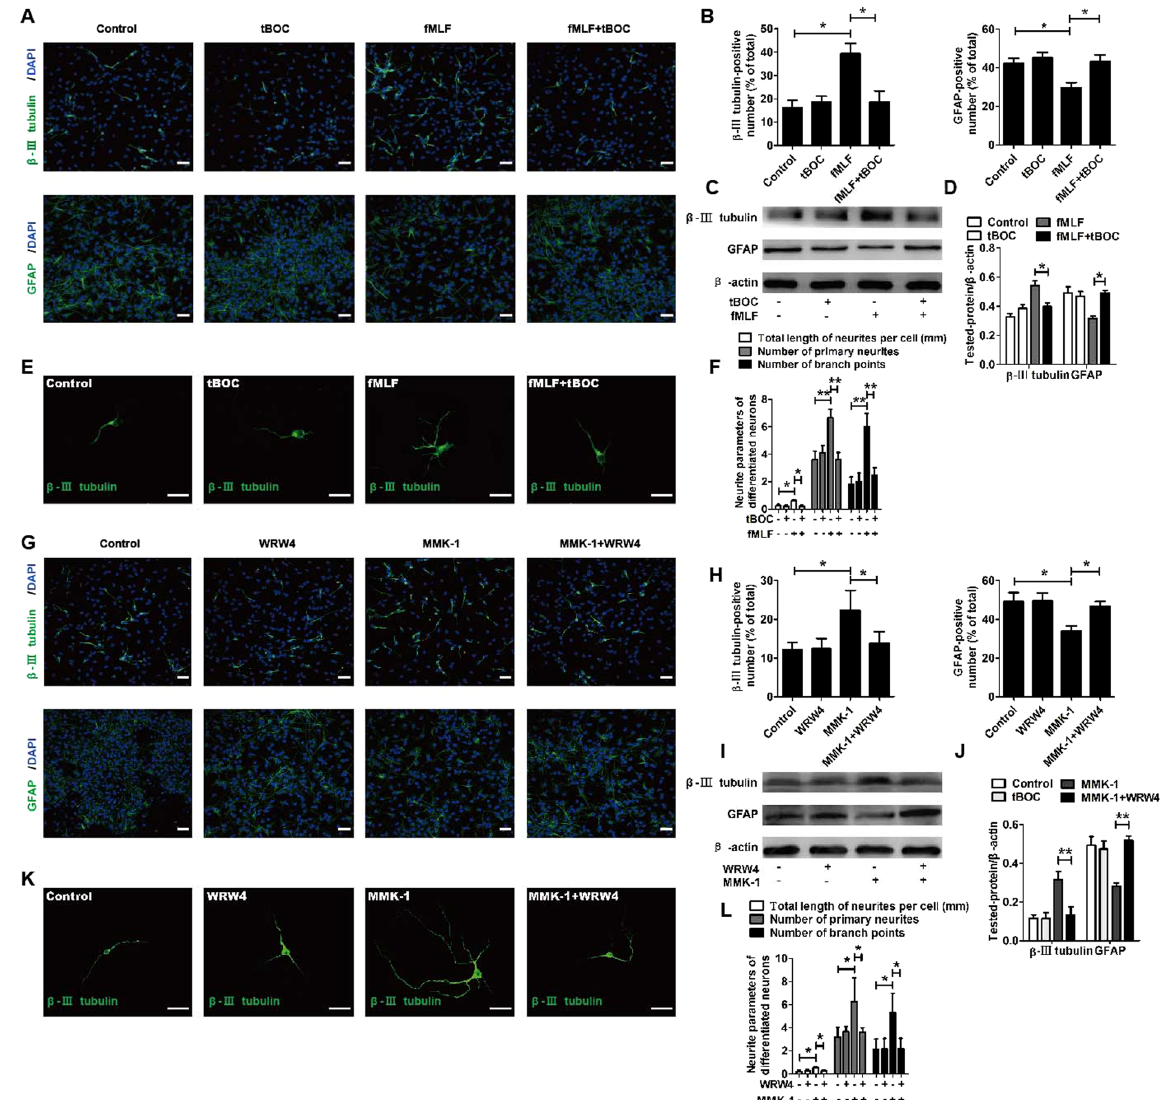
Figure 3. Promoting effects of Fprs on neuronal differentiation of NSCs were blocked by FPRs antagonist. ( A–F ) Promoting effects of Fpr1 on neuronal differentiation of NSCs were blocked by FPR1 antagonist. ( A,B ) Dissociated NSCs were differentiated for 6 days with or without preadministering tBOC, an FPR1 inhibitor, for 30 min before administering fMLF. The differentiated cells were then identified by immunocytochemistry using antibodies against β -III tubulin and GFAP. The images in ( A ) are representative of several independent experiments, and the graph in ( B ) shows the statistical results. ( C ) Representative immunoblots. ( D ) Histograms showing relative levels of β -III tubulin and GFAP. ( E ) Dissociated NSCs were differentiated in an extremely low density (1000 cells/mL), and then the cells were immunostained with β -III tubulin. ( F ) Quantified analysis of total length of neurites per cell, the number of primary neurites, and the number of branch points. ( G–L ) Promoting effects of Fpr2 on neuronal differentiation of NSCs were blocked by FPR2 antagonist. ( G,H ) Dissociated NSCs were differentiated for 6 days with or without preadministering WRW4, an FPR2 inhibitor, for 30 min before administering MMK-1. The images in ( G ) are representative of several independent experiments, and the graph in ( H ) shows the statistical results. ( I ) Representative immunoblots. ( J ) Histograms showing relative levels of β -III tubulin and GFAP. ( K ) Representative micrographs of the differentiated cells immunostained with β -III tubulin. ( L ) Quantified analysis of total length of neurites per cell, the number of primary neurites, and the number of branch points. Data were presented as mean ± SEM. * P < 0.05; ** P < 0.01; N = 4. Scale bar = 20 µ